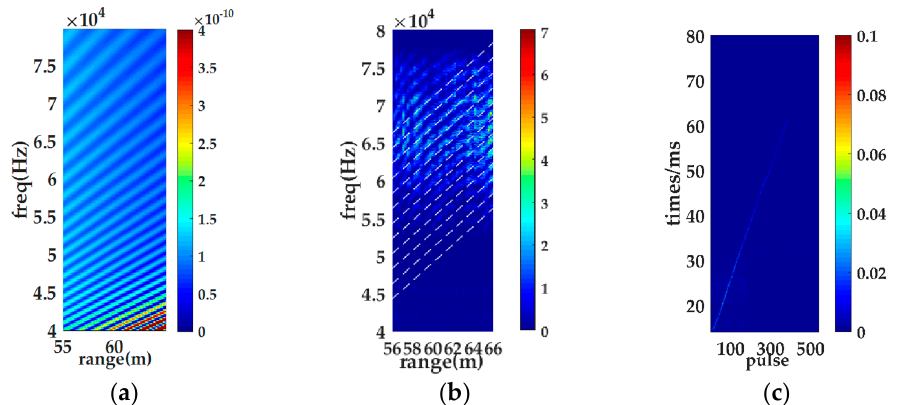
Figure 8. Comparison between the experiment result and the simulation result at 40 − 80 kHz: ( a ) simulation result; ( b ) experiment result; ( c ) the motion trajectory.